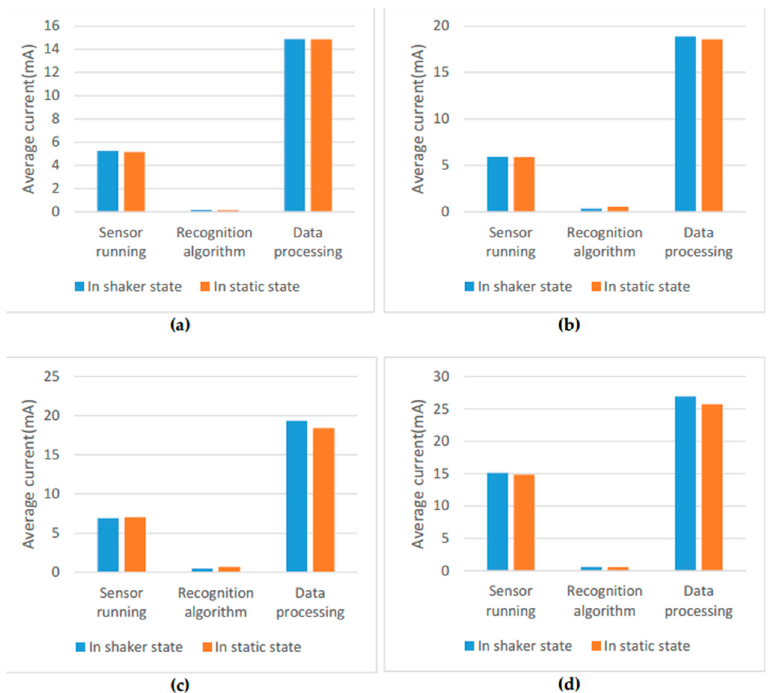
Figure 13. The average current in the sensor running, data processing and activity recognition. ( a ) ARS with a sampling rate of 1 Hz; ( b ) ARS with a sampling rate of 5 Hz; ( c ) ARS with a sampling rate of 10 Hz; ( d ) ARS with a sampling rate of 50 Hz.